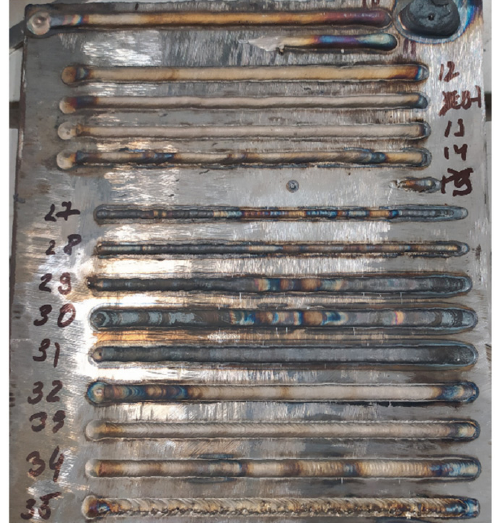
Figure 4. Photo of bead-on-plate